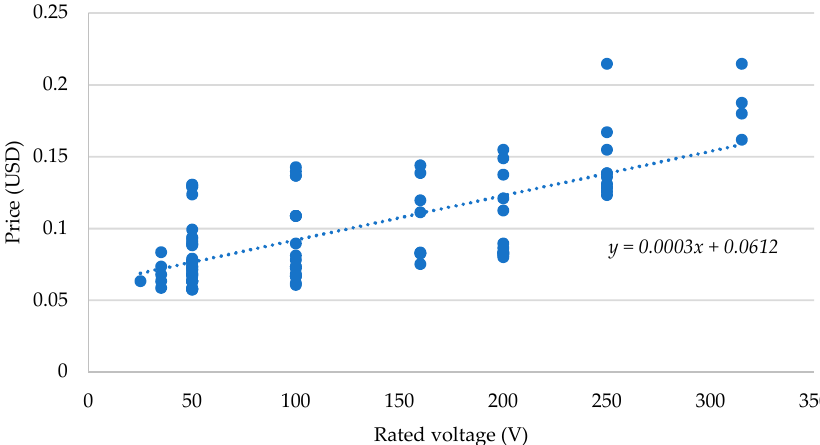
Figure 10. Price distribution of electrolytic capacitor by rated voltage.